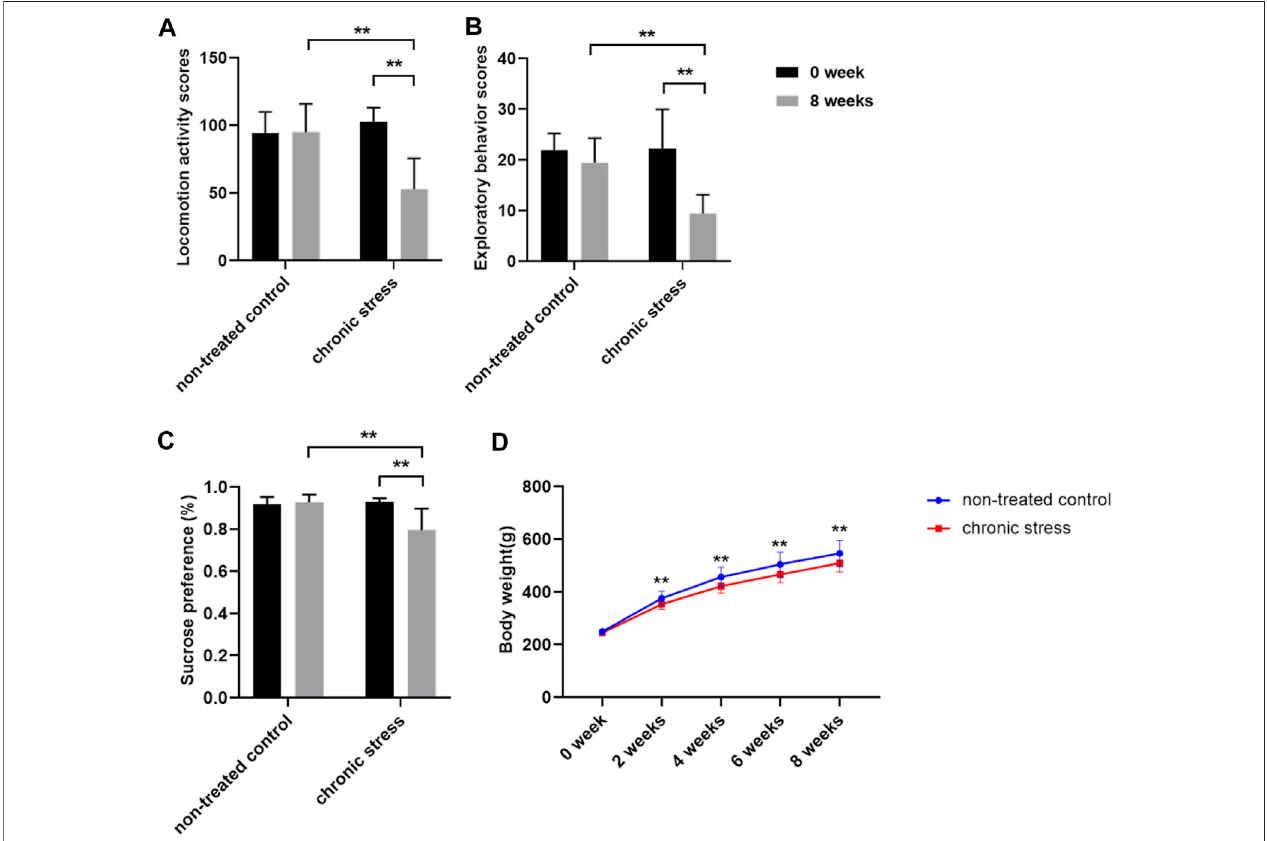
FIGURE 1 | Chronic stress model was established successfully ( n = 20/group). (A) Locomotion activity scores. (B) Exploratory behavior scores. (C) Sucrose preference. (D) Body weight. Data were expressed as mean ± SD. ** p < 0.01 (statistical comparisons between the two groups were performed using the two independent sample t-test, and the same group was performed with the paired sample t-test. Repeated measurement data was performed using two-way repeated measures ANOVA.).